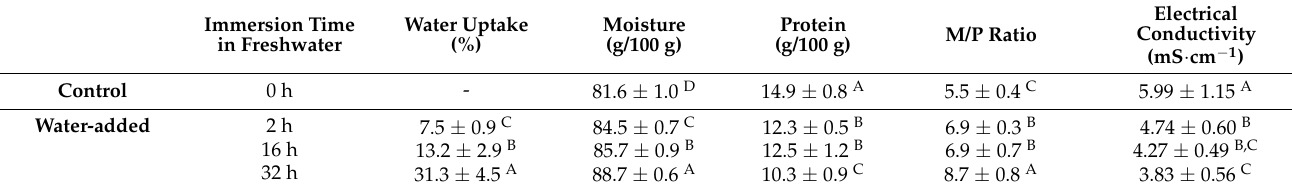
Table 2. Water uptake, moisture and protein contents, and electrical conductivity of Octopus vulgaris samples from the validation trial. Twelve octopus were sampled for control and for each immersion time treatment. Different superscript letters (A–D) denote significant differences between immersion time treatments. Abbreviations: M/P ratio, moisture/protein ratio.